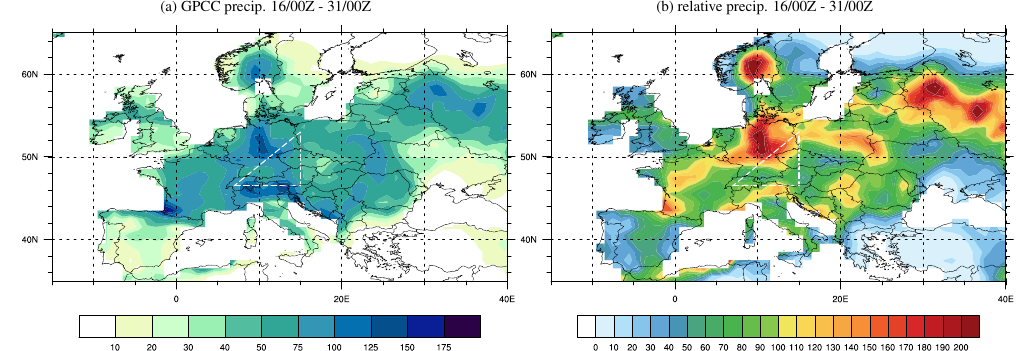
Figure 1. (a) : observed precipitation over land (shaded in mm) from first guess GPCC data accumulated from 16 May 2013, 00:00UTC to 31 May 2013, 00:00UTC and (b) : fraction of total climatological May precipitation that fell during this 15day period (shaded every 10%, blue < 50%, green 50–100%, yellow 100–150%, red >